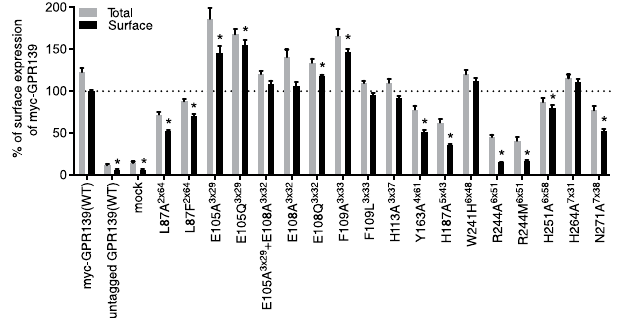
Figure 2. Total and surface expression of GPR139 mutants. Cell surface expression profiles of each of the human GPR139 mutants compared to myc-GPR139(WT). Grey bars = total expression (triton-X treated), black bars = surface expression. Data is mean ± S.E.M. of 4–8 independent experiments performed in triplicates. Statistical analysis was performed on the surface expression using one-way ANOVA followed by Dunnett’s post- hoc test in comparison with the surface expression of myc-GPR139(WT) ( * P < 0.01).